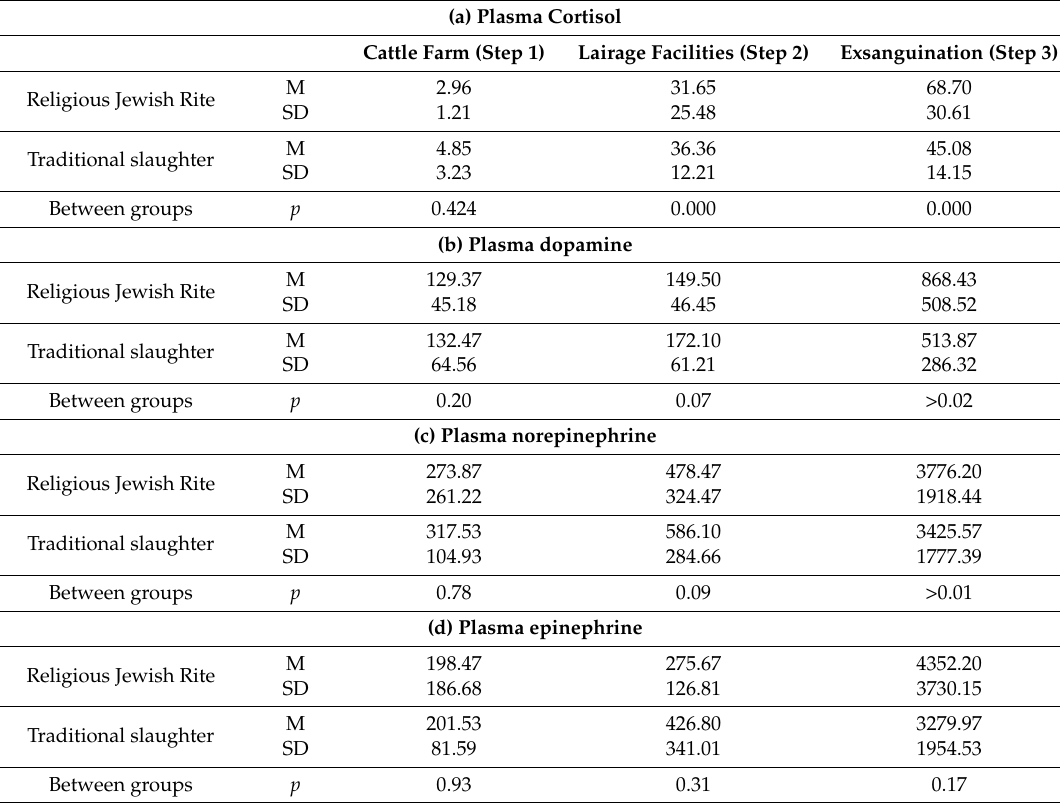
Table 1. Mean values (M), Standard Deviation (SD) and Significance Level ( p ) between groups.